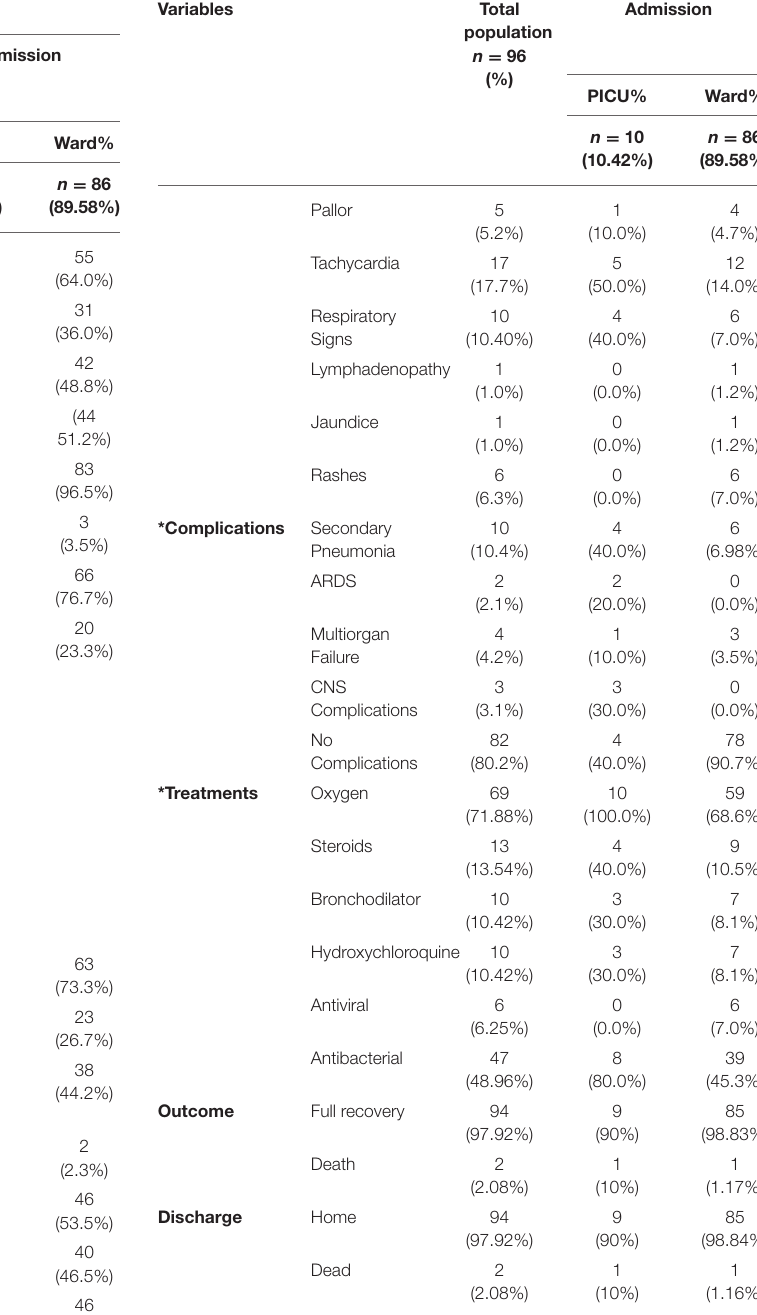
TABLE 2 | Patients demographics and disease characteristics with PICU vs. regular ward admission of children admitted with confirmed COVID-19 infection ( n =